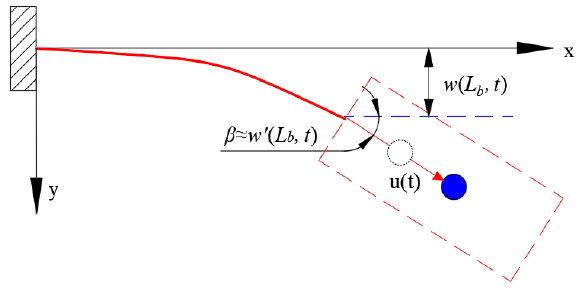
Figure 3. Deformation diagram of the cantilever beam.